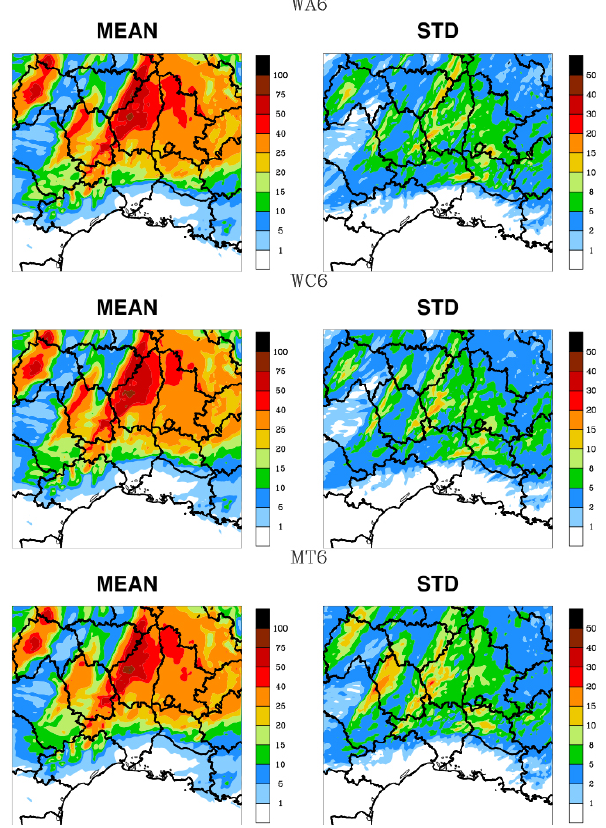
Fig. 8. Mean and standard deviation of the 24h accumulated rainfall for the WA6 (top), WC6 (middle) and MT6 (bottom) ensembles.